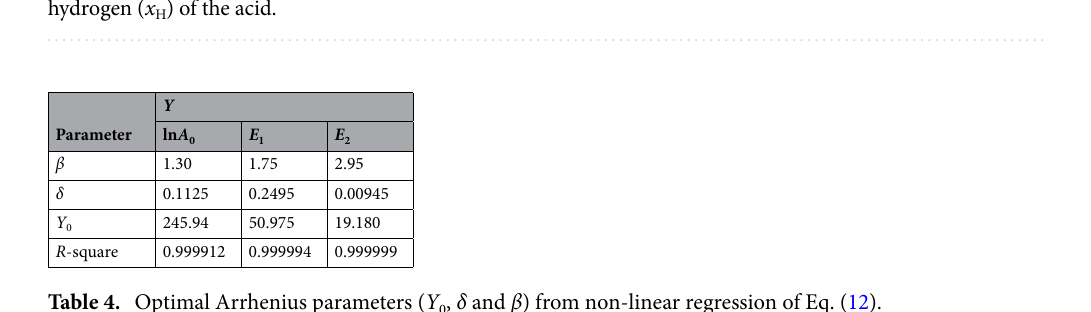
Figure 4. Variation of the three adjustable parameters ( E i and ln A 0 ) of Eq. (5) as a function of the number of hydrogen ( x H ) of the acid.